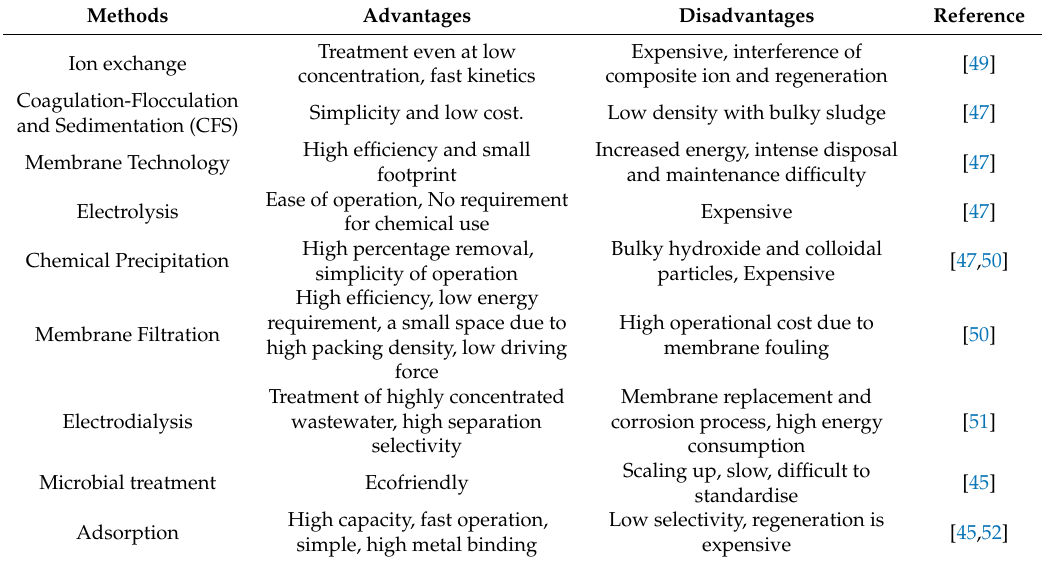
Table 3. Advantages and drawbacks of conventional methods for copper ions sequestration from aqueous solution